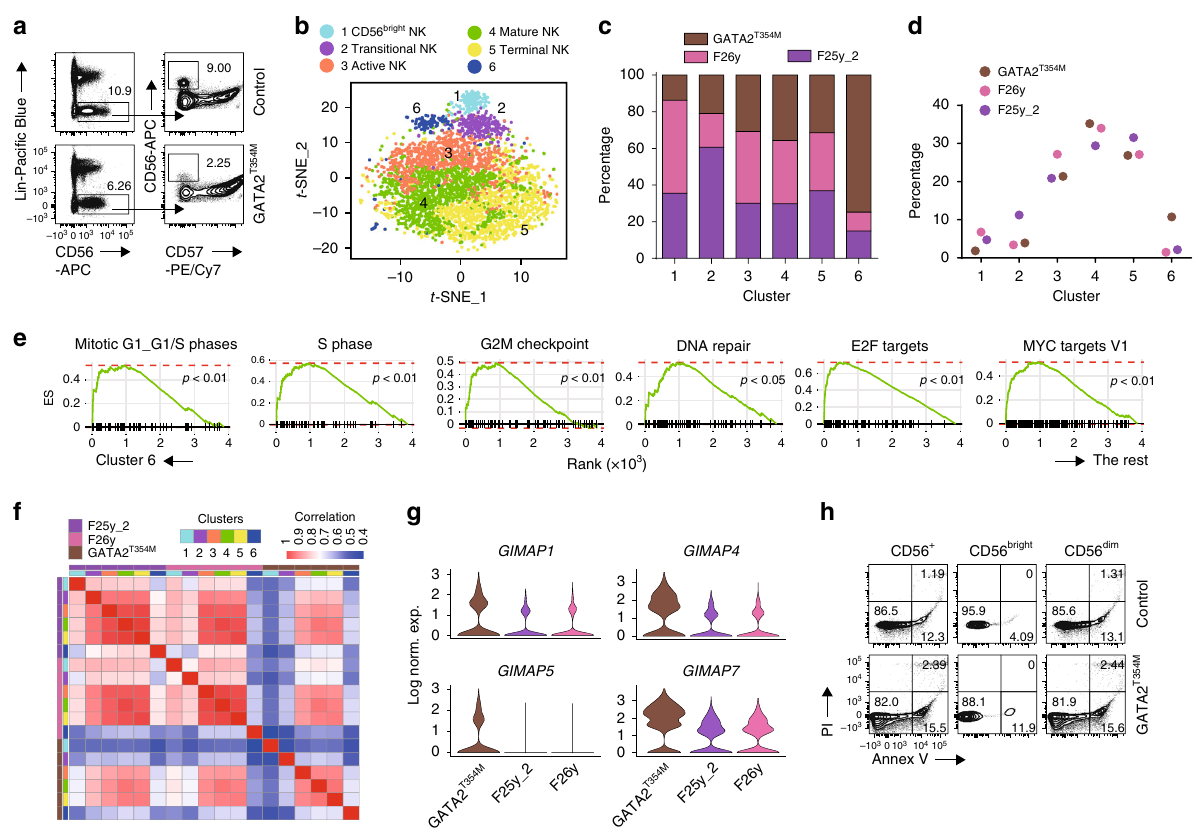
Fig. 9 GATA2 mutation results in larger transcriptome alteration in CD56 bright NK cells compared to CD56 dim NK cells. a The blood samples from the GATA2 T354M donor and the healthy control were freshly collected and processed at the same time. Lin − CD56 + NK cells were evaluated via fl ow cytometry. The CD56 bright NK cells were identi fi ed with the help of CD57. b The combined analyses of the blood samples from the GATA2 T354M donor and the two healthy controls resulted in six clusters, as shown in the t -SNE plot. c Composition of the donors within each cluster. The input cell number from each donor is normalized to be equal. d Composition of the clusters within each donor. e Selected gene sets from the GSEA enriched in the Cluster #6 of the GATA T354M donor sample compared to the rest of the cells. f Spearman ’ s correlational matrix was used to compare the average gene expression among each cluster from each donor. g Four of the top 10 up-regulated DEGs of the GATA2 T354M donor NK cells belonged to the GIMAP family and were shown in violin plots. The y -axis represents log-normalized expression value. h The viability of NK cells from the GATA2 T354M donor and the healthy control were evaluated using Annexin V/PI staining. Source data for c and d are provided as a Source Data fi le. See also Supplementary Fig.